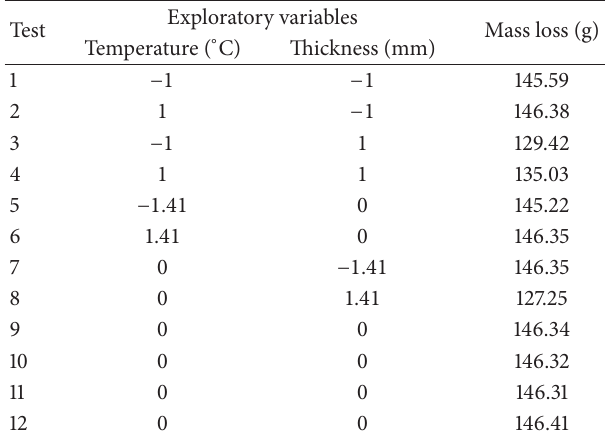
Table3:Analysisofvariance(ANOVA)fortomatomasslosssubject to different times and temperatures during drying process.